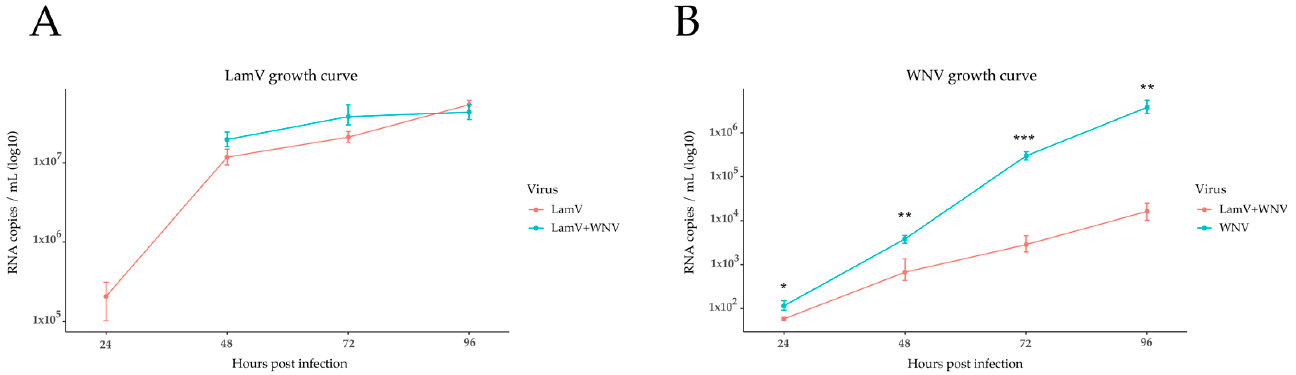
Figure 1. Growth curves of LamV and WNV in U4.4 cells, shown as RNA copies/mL over time. ( A ) LamV growth curve. ( B ) WNV growth curve. Dots show the mean RNA copy number per mL with a standard deviation among the biological replicates. * p < 0.05, ** p < 0.01, *** p < 0.001.